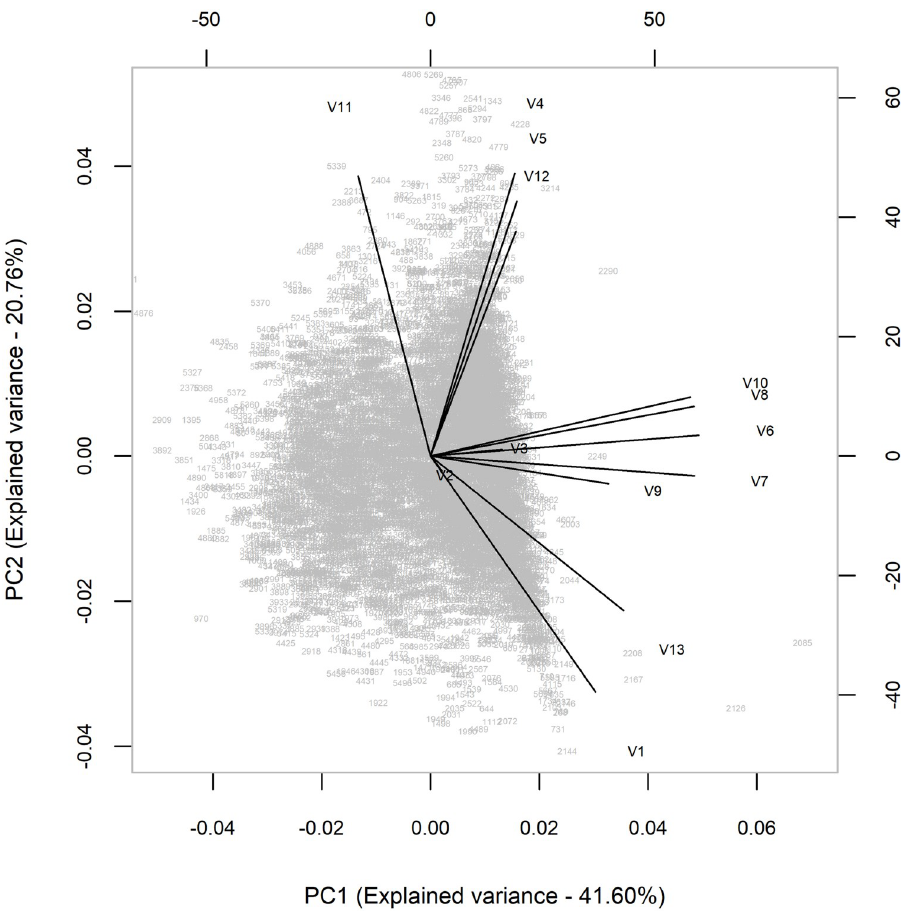
Fig 1. Biplot graph used to identify key predictors of dengue incidence in Vietnam among 13 meteorological variables (2001–2009).